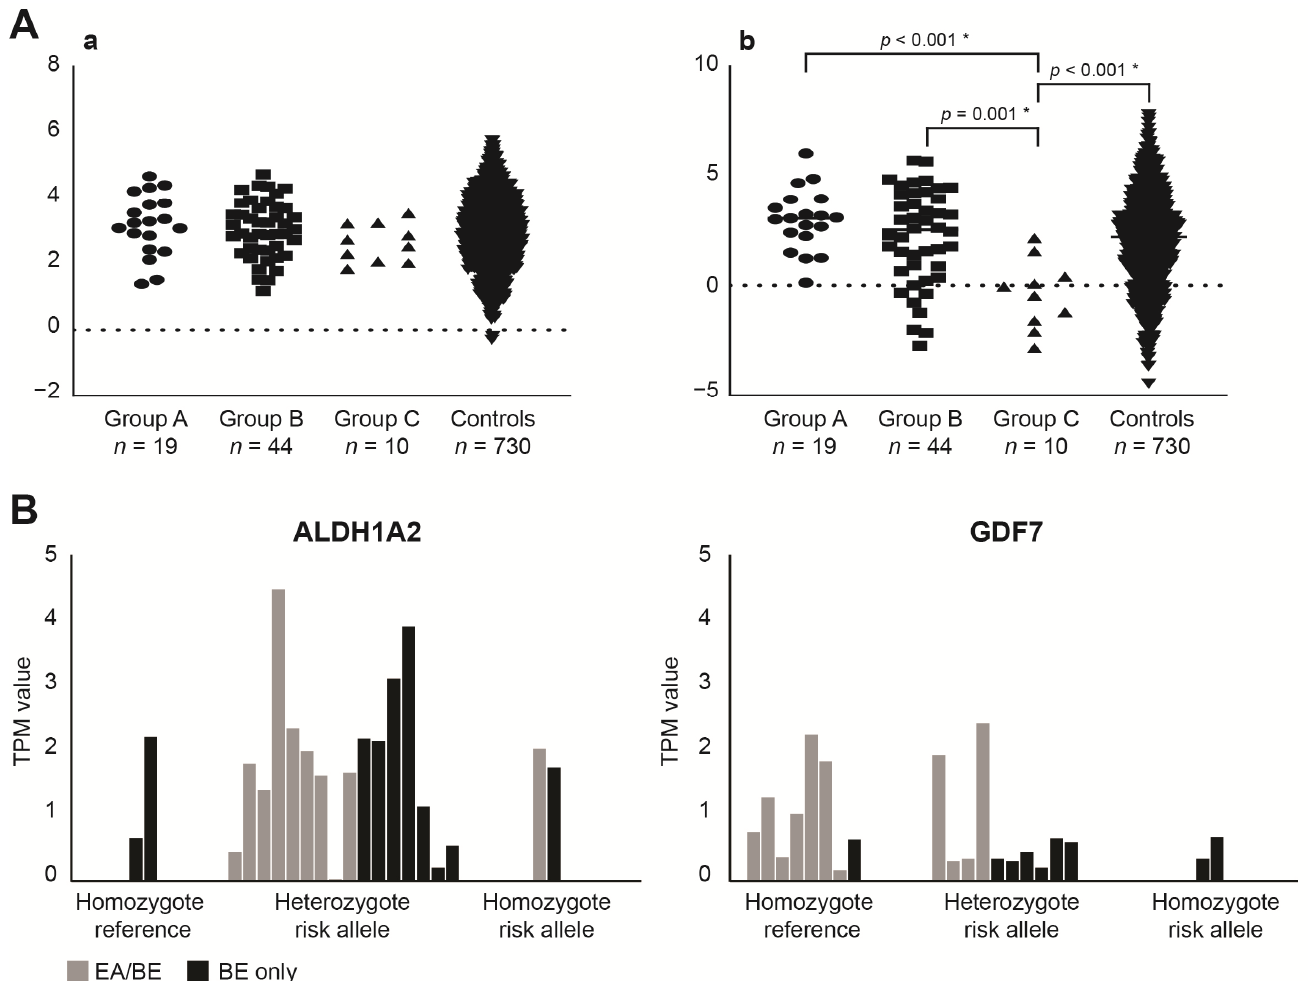
Figure 2. ( A ) Polygenic risk scores (PGRS) per patient. Group A = patients with esophageal atresia (EA) and Barrett’s esophagus (BE), group B = patients with EA without BE, group C = patients with BE without EA in history. Panel a (left) are PGRS based on odds ratios (ORs) selected from the literature. No statistical significant differences between the groups were observed. Panel b (right): PGRS based on ORs calculated from our study population. We found a median PGRS of 3.05 (range 0.14–6.04) for EA/BE patients, of 2.52 ( − 2.73–5.72) for EA-only patients and of − 0.24 ( − 2.83–2.15) for BE-only patients. A Kruskal–Wallis test revealed a significant difference in PGRS based on ORs calculated from our study population between the four groups ( p = 0.001). T-statistics indicated a difference between BE-only patients versus EA/BE patients ( p < 0.001), EA-only patients ( p = 0.001) and controls ( p < 0.001). Asterisk (*) indicates significance p<0.05. ( B ) Gene expression levels for ALDH1A2 and GDF7 per patient, sorted based on the genotype of the patients. A higher risk allele frequency was found for EA/BE patients versus BE-only patients for rs3784262 near ALDH1A2 ( p = 0.017) and a putative protective allele for rs3072 near GDF7 ( p = 0.009). Looking at gene expression levels, GDF7 has slightly elevated TPM values for patients homozygote for the reference allele. No significant differences could be detected for these two associated SNPs. TPM = transcripts per million, EA = esophageal atresia, BE = Barrett’s esophagus. Complete results can be found in supplementary table S3-S6.